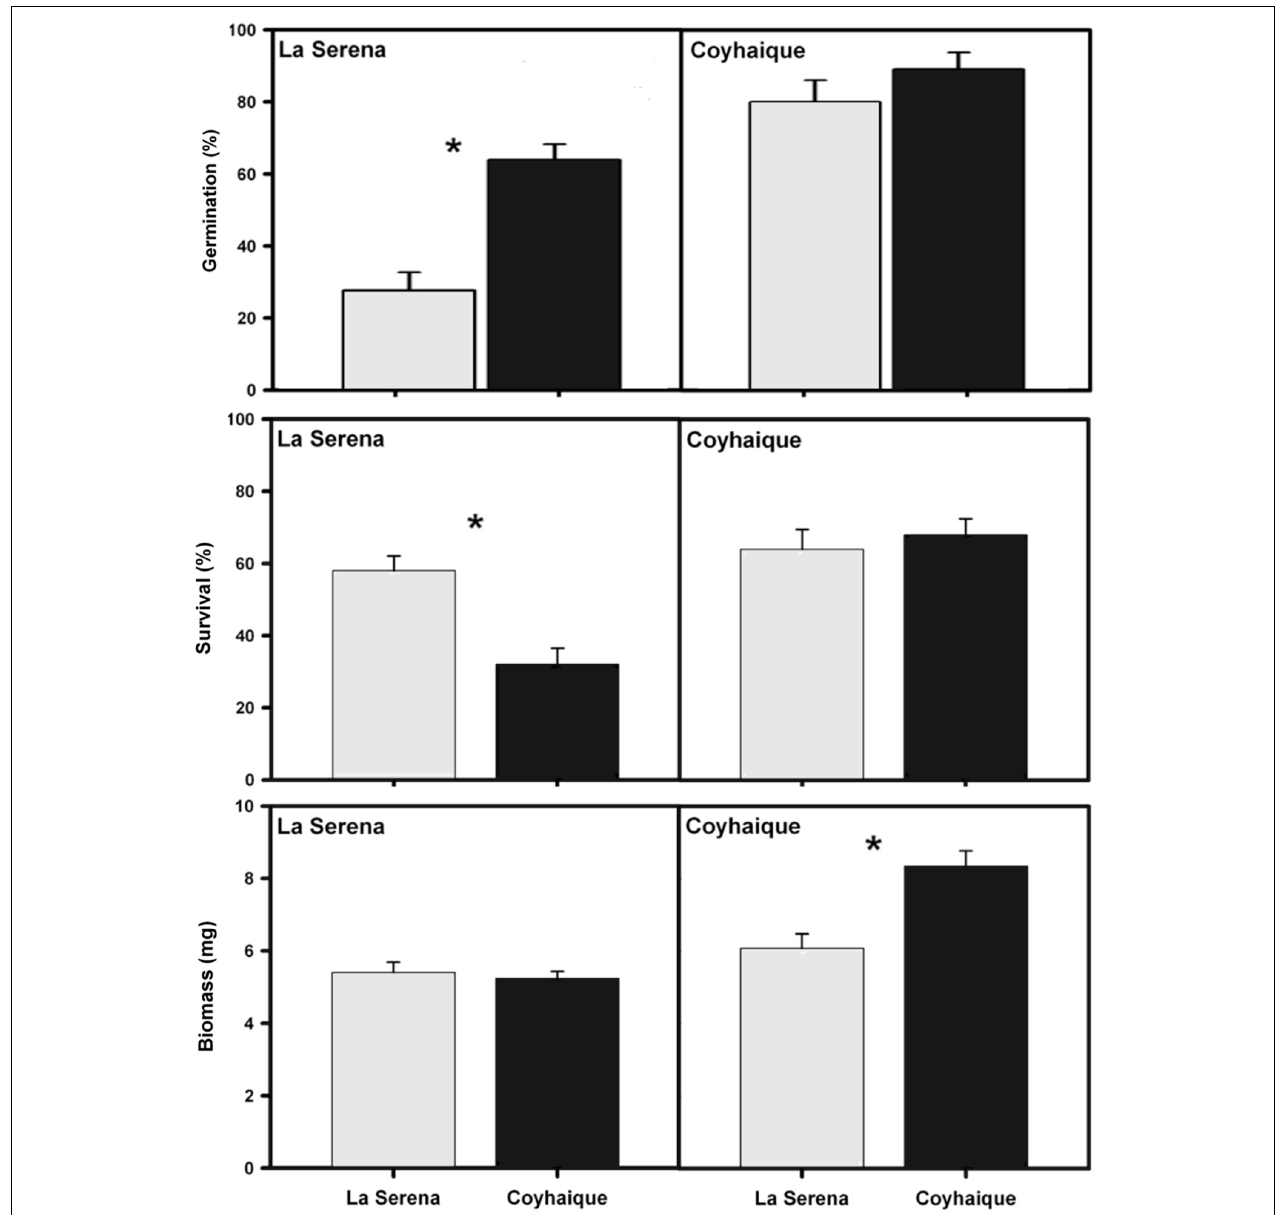
FIGURE 4 | Mean values ( ± 2 SE) of germination percentage, survival percentage and total biomass (mg of dry weight per plant) of T. officinale individuals from La Serena and Coyhaique and put in both La Serena and Coyhaique. The locality name in the upper-left corner of each box denotes the place where transplants were made. Asterisk indicates significant